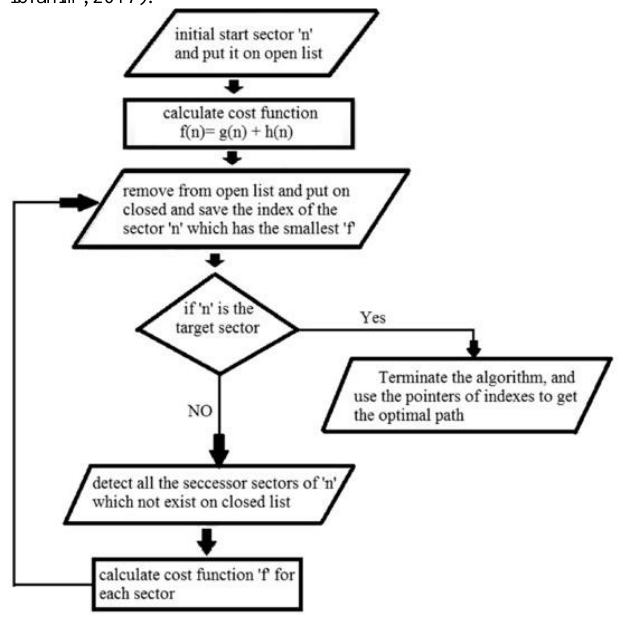
Figure 1. The flowchart of A *